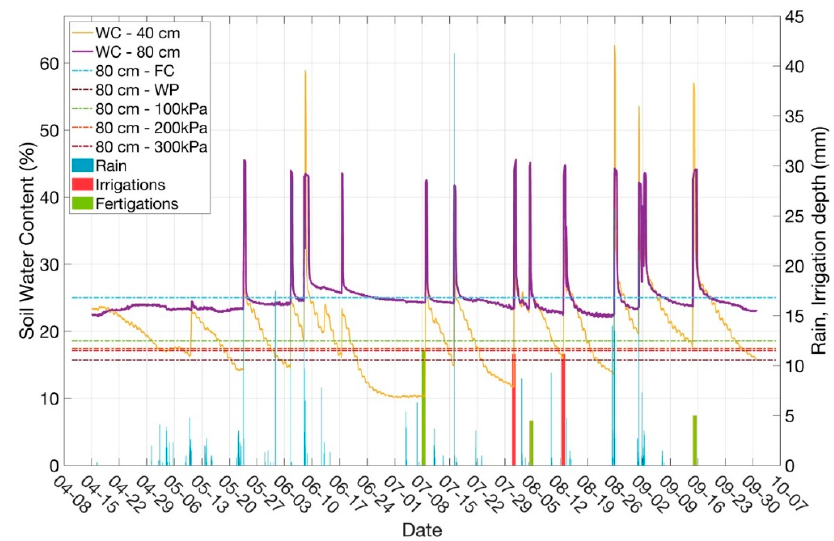
Figure 6. Soil water content measured by the WSN probes for Sector 1-2-1 in the period April– September 2018. The reported FC, WP and − 100 kPa, − 200 kPa, − 300 kPa thresholds refer to the 80 cm horizon only; irrigation, fertigation and rainfall events and are also reported.